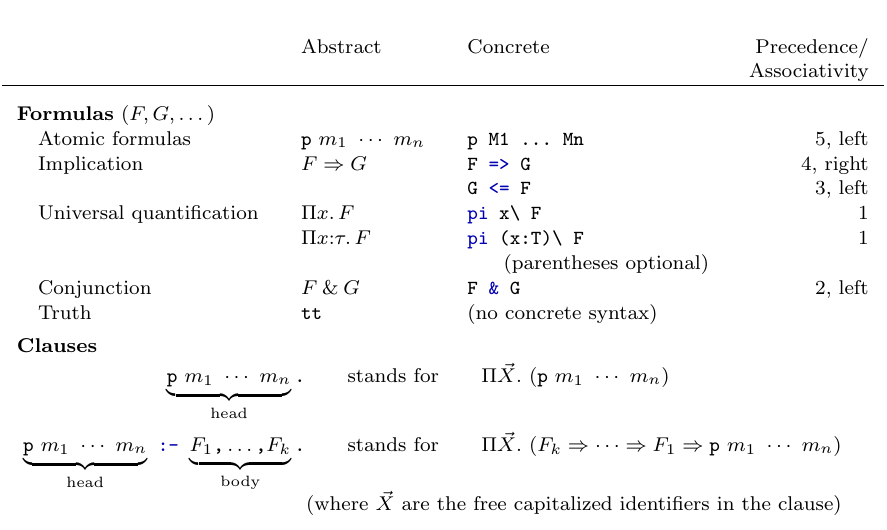
Fig. 5: Concrete Syntax for hereditary Harrop formulas and specification logic